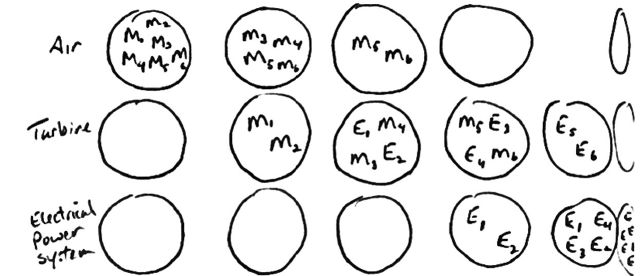
FIG. 9. A learner-invented “ energy tracking snapshots ” dia- gram for a wind turbine